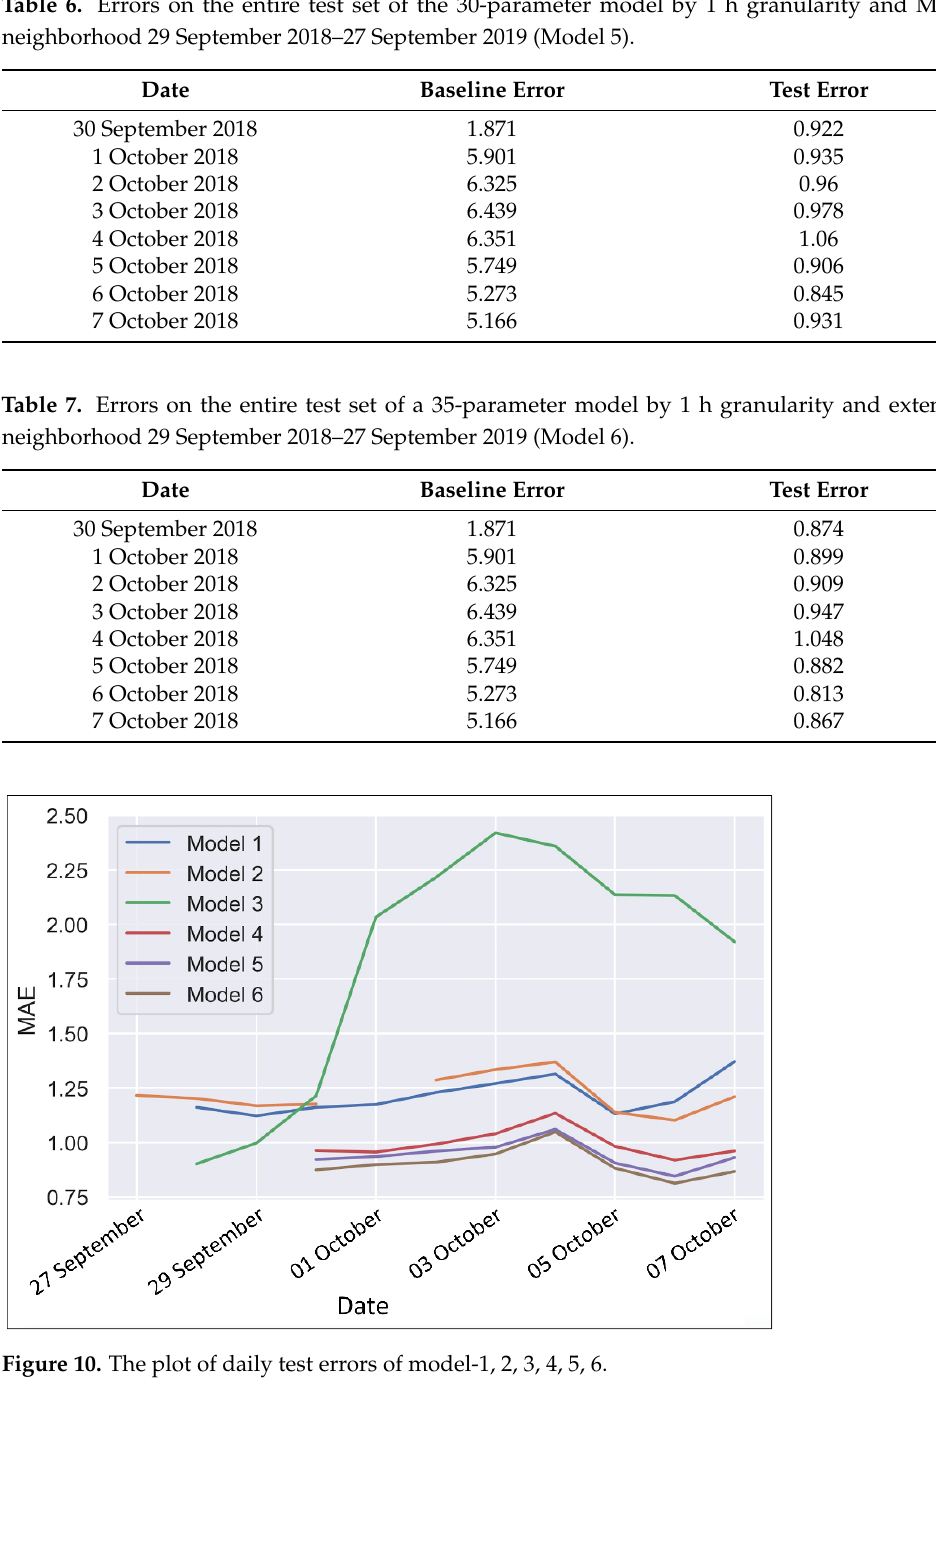
Table 6. Errors on the entire test set of the 30-parameter model by 1 h granularity and Moore neigh-